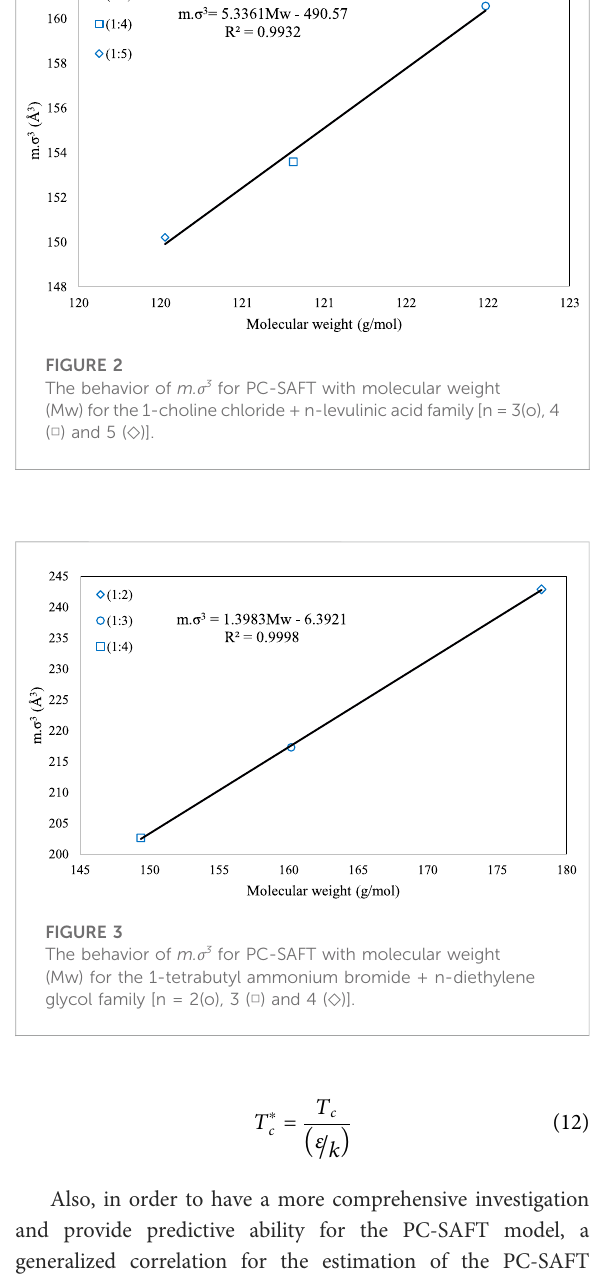
Figure 1. In this fi gure, the relations of m σ 3 of the PC-SAFT